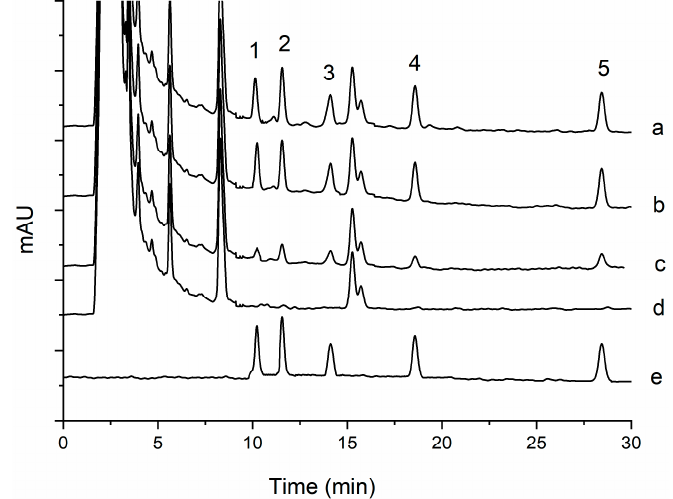
Figure 7. Typical chromatograms of five pyrethroids in oral yimucao liquids under optimum conditions: (1) transfluthrin, (2) fenpropathrin, (3) fenvalerate, (4) etofenprox, and (5) silafluofen. In chromatograms (a, c, d), the spiked levels are 100, 20, and 0 ng mL − 1 , and (b, e) show the standard solution in blank matrix and acetonitrile.